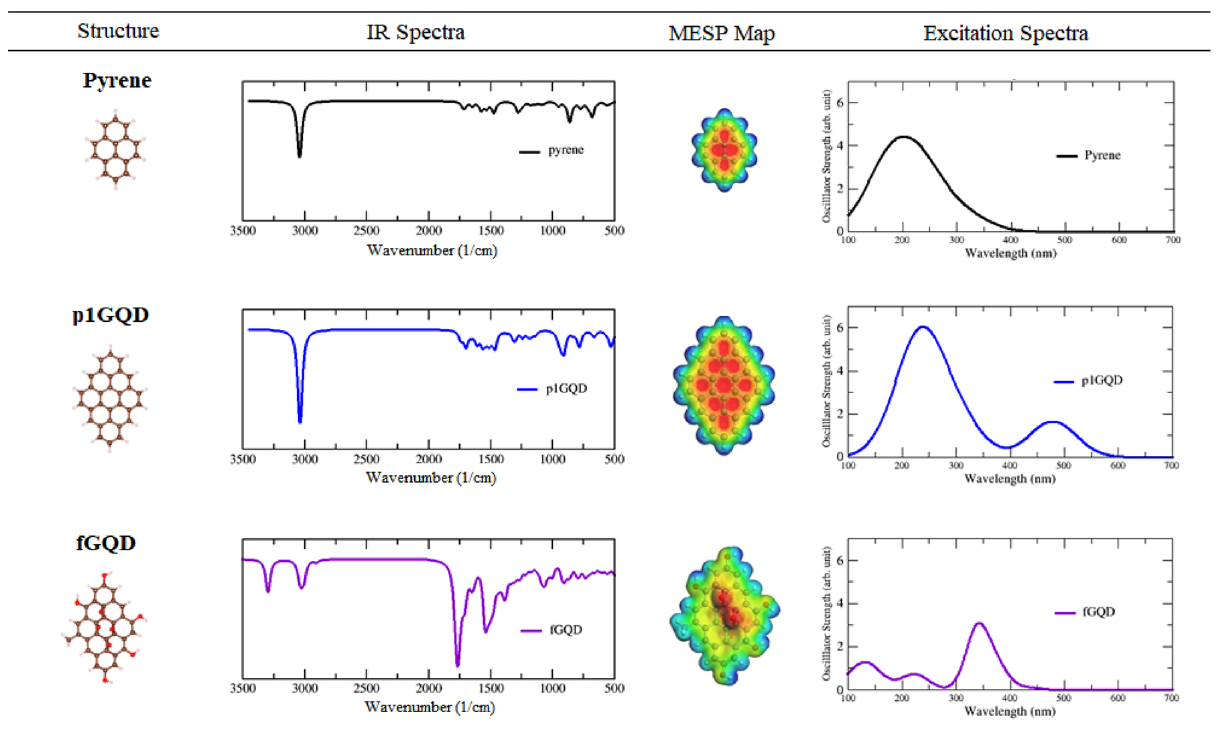
Table 3. Various pyrene-like molecular structures and their corresponding IR, MESP map, and excitation